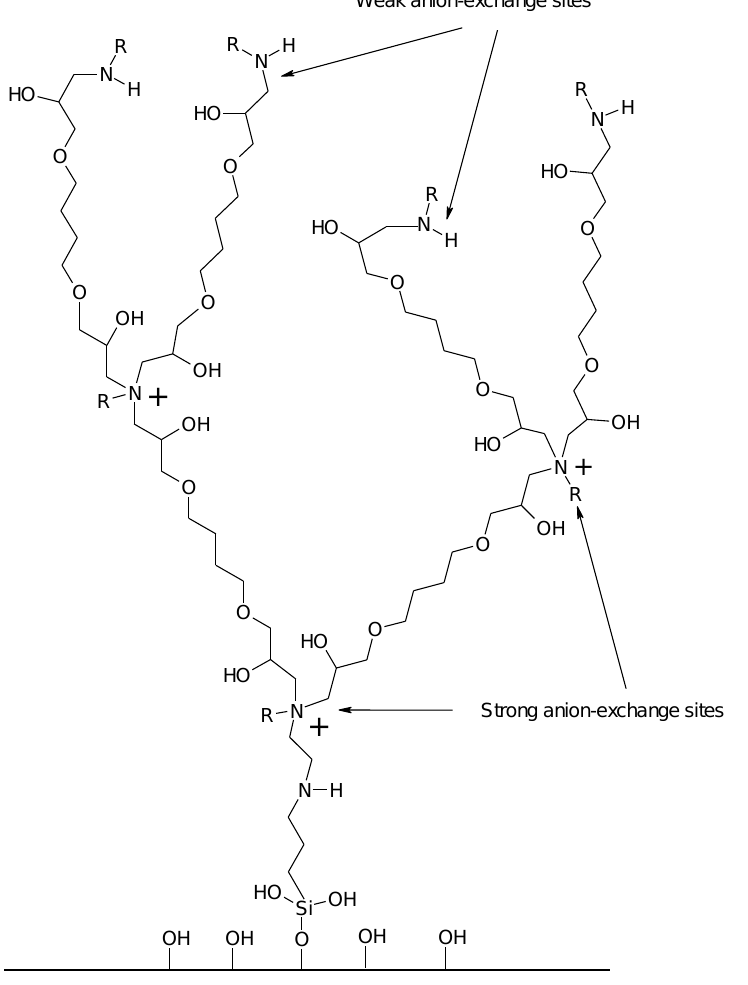
Figure 1. Schematic structure of dendrimer anion exchanger obtained after two reaction cycles. Table 1. Elemental composition of prepared series of anion exchangers.